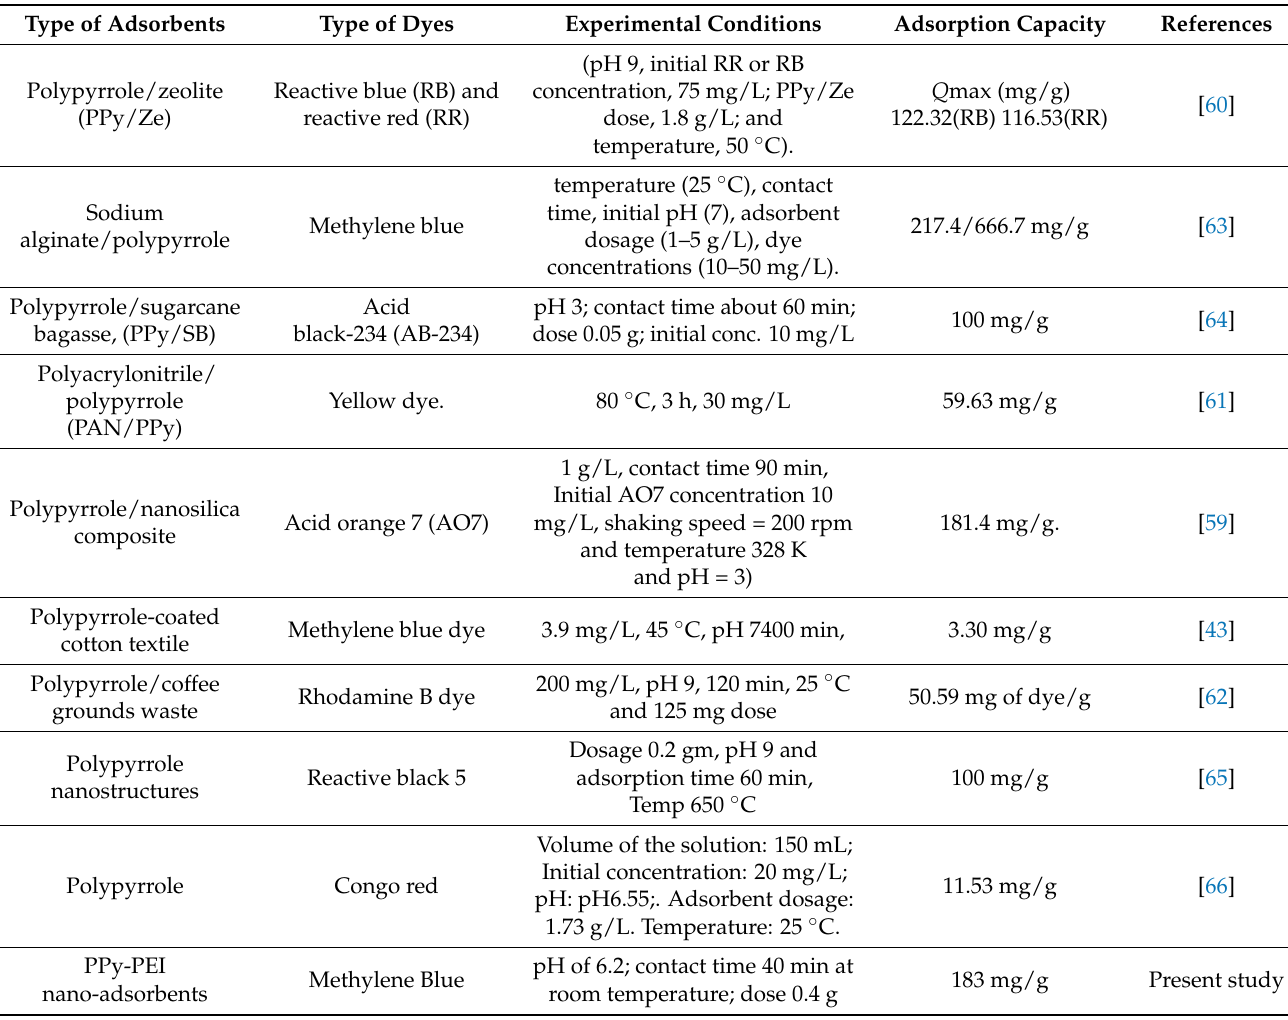
Table 3. Comparative profile of polypyrrole based adsorbent for the adsorption of dyes. Type of Adsorbents Type of